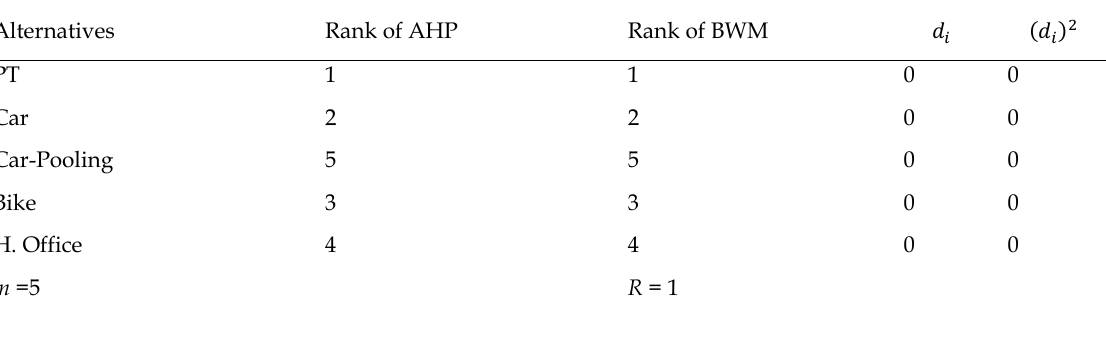
Spearman’s rank correlation coefficient for Group 2